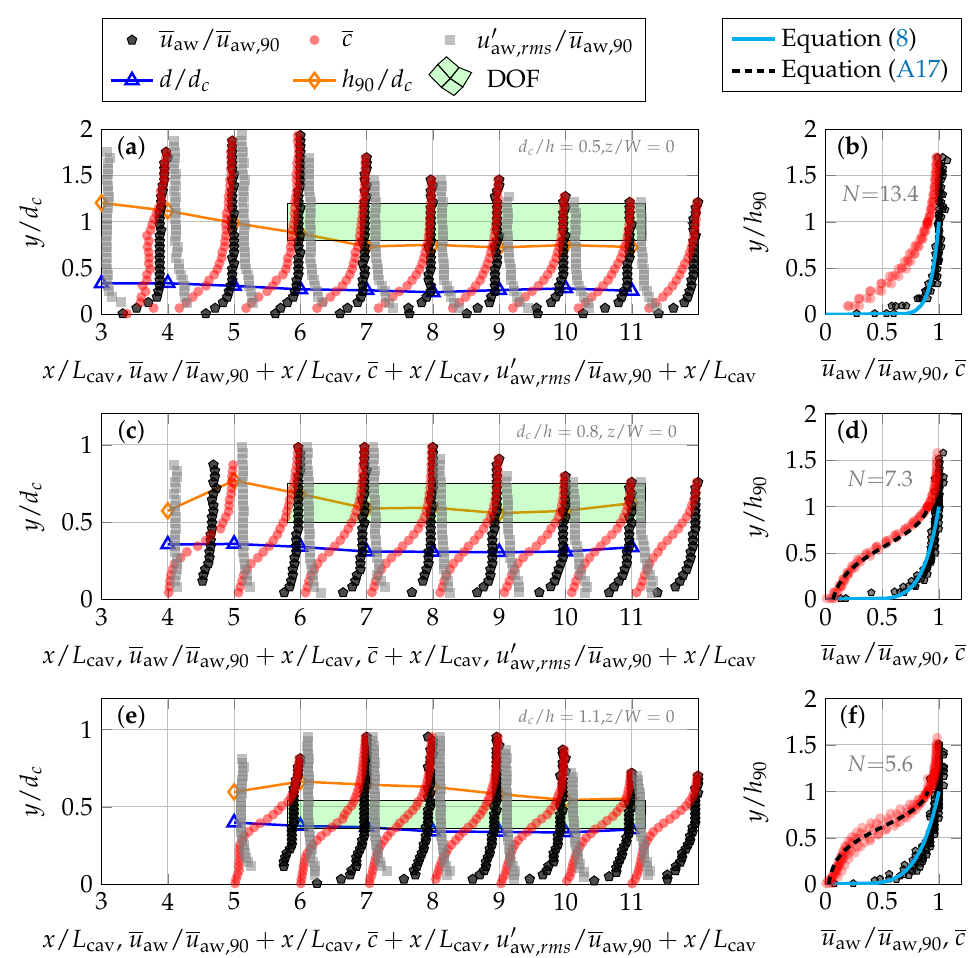
Figure 4. Air–water flow properties in centerline; ( a , c , e ) development of interfacial velocity ( u aw ), volumetric air concentration ( c ), turbulence level ( u (cid:48) aw, rms ), clear water flow depth ( d ), and mixture flow depth ( h 90 ) along the aerated flow region; ( b , d , f ) normalized velocity and air concentration distributions for x / L cav = 8 to 11—comparison with Equations (8) and